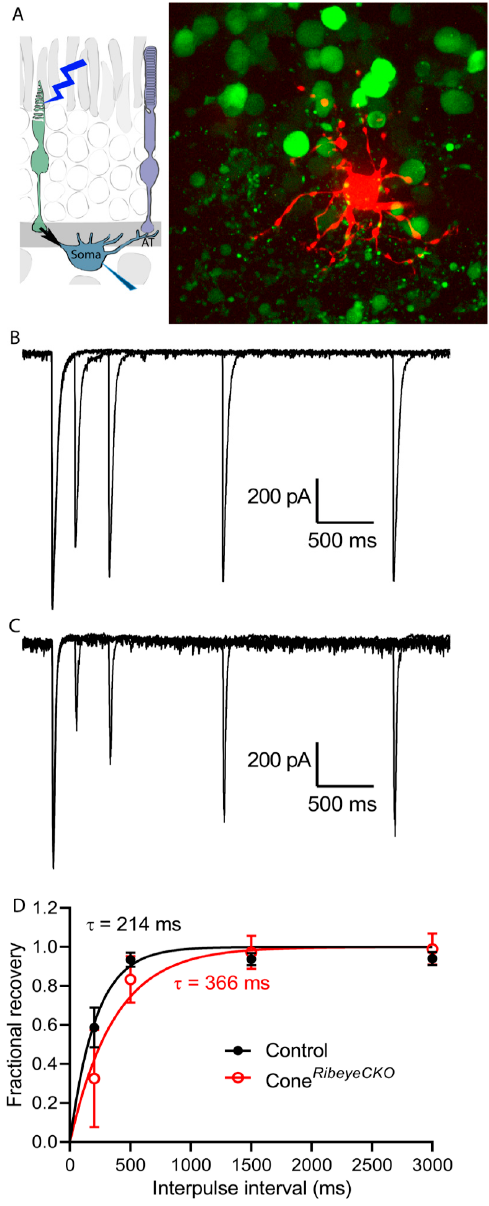
Figure 11. Loss of ribbons slowed down recovery from paired pulse depression in cones assessed by optogenetic stimulation of postsynaptic currents in horizontal cells. ( A ) Diagram illustrating optogenetic stimulation of cones while recording from a horizontal cell. The photomicrograph shows a horizontal cell filled with sulforhodamine B through a patch pipette (red) within horizontal retinal slice preparation. The retina was also loaded with a Ca 2+ -sensitive dye, Cal520 (green), revealing some underlying cones. ( B ) Example horizontal cell current recordings showing responses to a series of paired pulse trials obtained with optogenetic flashes applied at different inter-pulse intervals (200, 500, 1500, 3000 s). The responses in ( B ) are from a horizontal cell in C57Bl6J control mouse retina while ( C ) illustrates paired pulse trials from a cone Ribeye CKO horizontal cell. ( D ) Plots amplitude of the horizontal synaptic current evoked by the second flash relative to the current amplitude evoked by the first flash in each trial. Responses recovered with a time constant of 214 ms (K = 0.004665 ± 0.0003175) in the control retinas ( n = 11 horizontal cells in four mice), but more slowly in the cone Ribeye CKO retinas ( n = 10 horizontal cells in four mice) with a time constant of 366 ms (K = 0.002732 ± 0.0003716 ms; p = 0.0002,